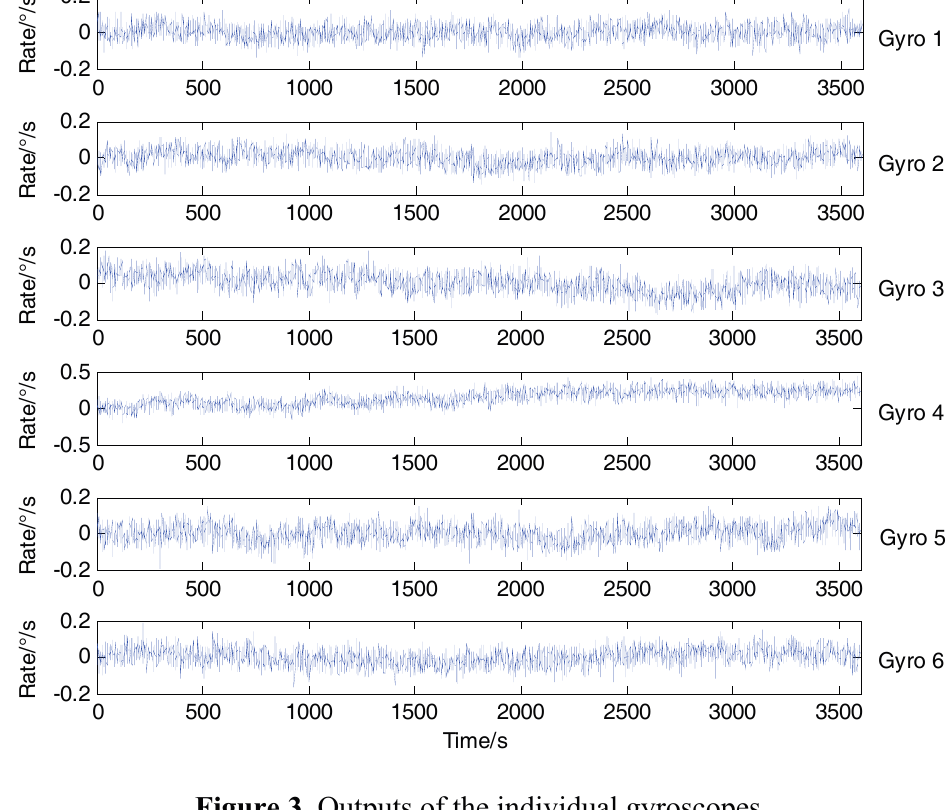
Figure 3. Outputs of the individual gyroscopes.